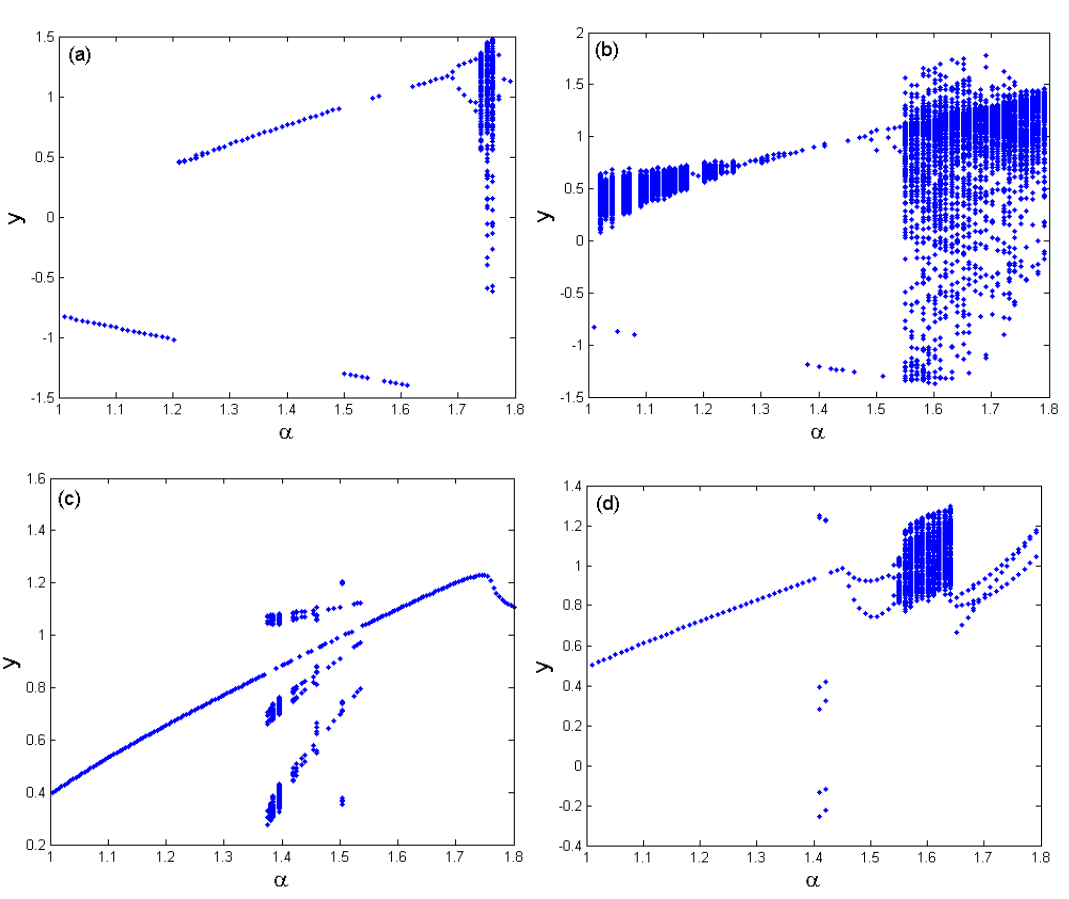
Figure 17. Bifurcation diagram of the equilibrium parameter α at different combined material parameters and external forcing terms: